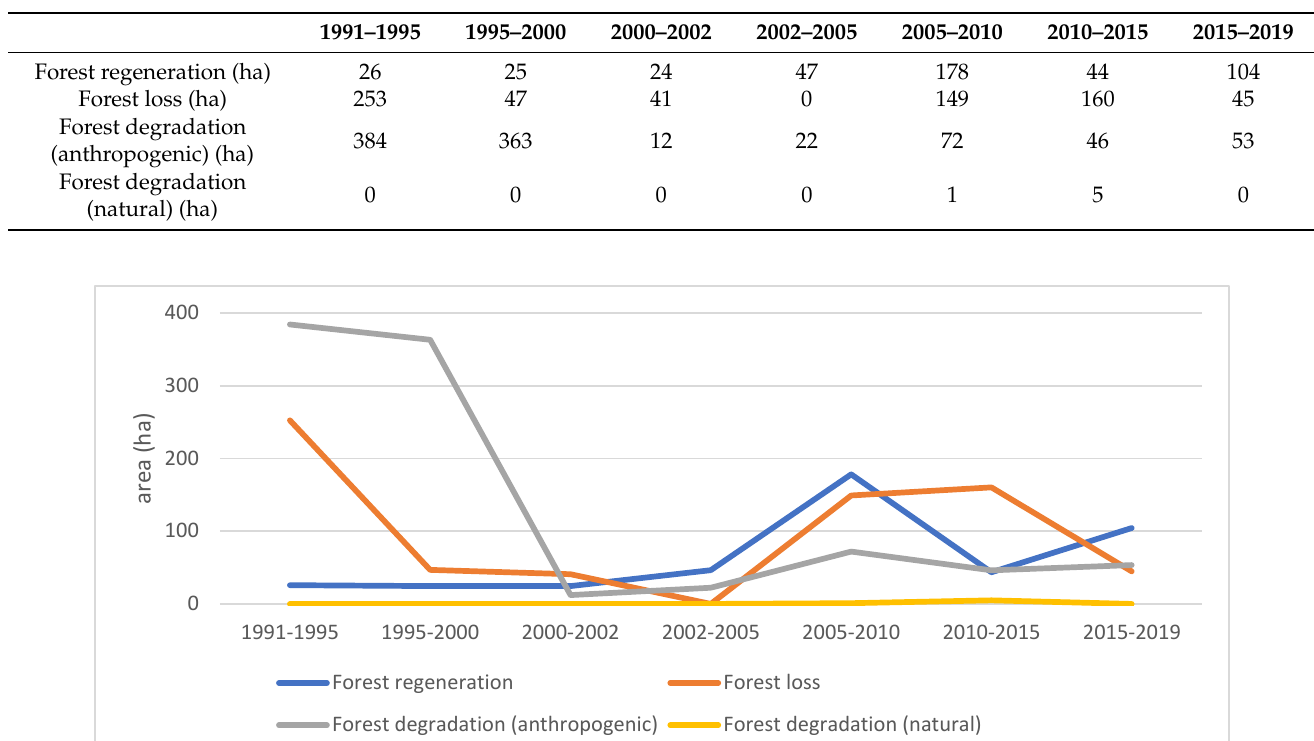
Figure 10 . Forest Type year 2019 .